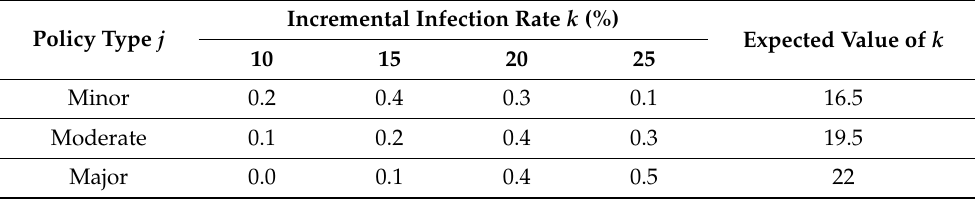
Table 8. Scenario 3: probabilities of incremental infection rates by policy type.